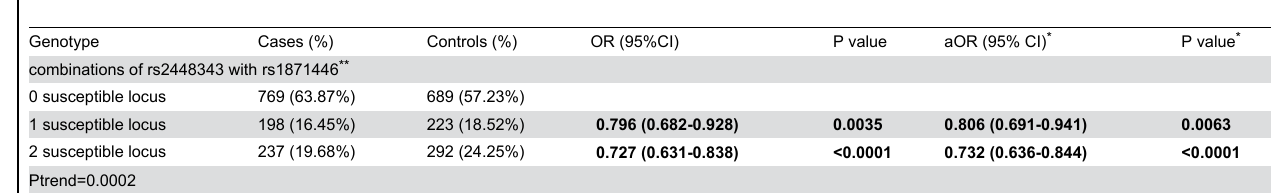
Table 2. Risk of breast cancer associated with the combination of 2 susceptible tSNPs in CDK1 .